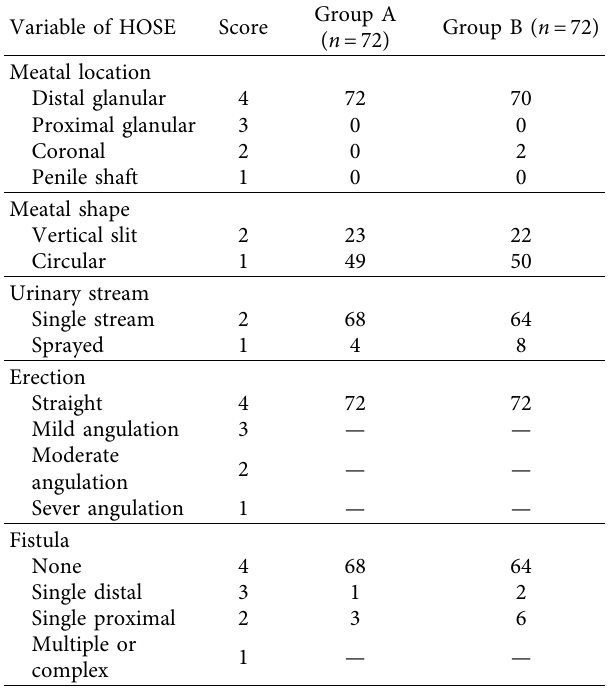
Table 3: HOSE score comparison between the two groups.